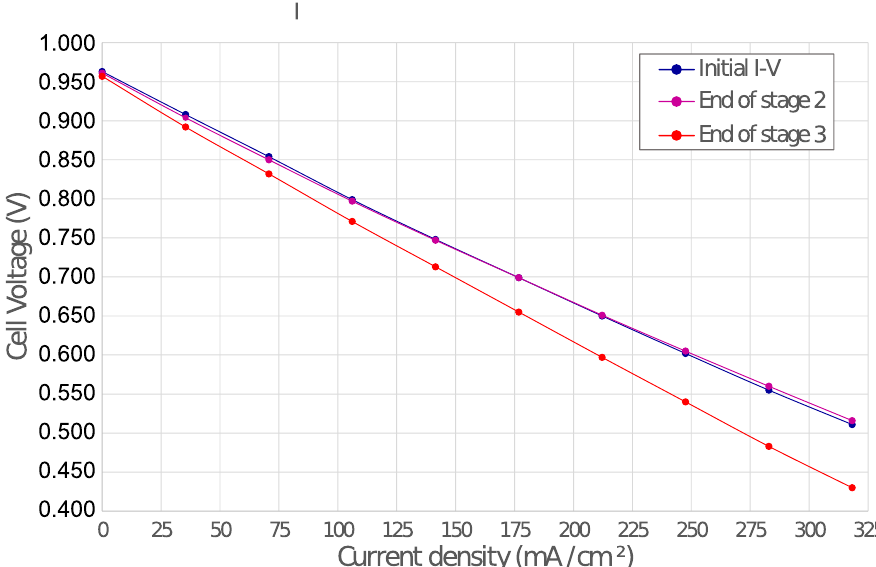
Figure 4. The performance of the cell at different stages of the short-term degradation test: Stage 1 is the I-V of the cell having been operated for a period of 50 h without any salt contamination. Stage 2 is the I-V for the cell after having been operated with salt contamination for 14 h at the rate of 1.6 ppm. Stage 3 is the I-V for the cell after having been operated with increased salt contamination of 250 ppm for 50 h.